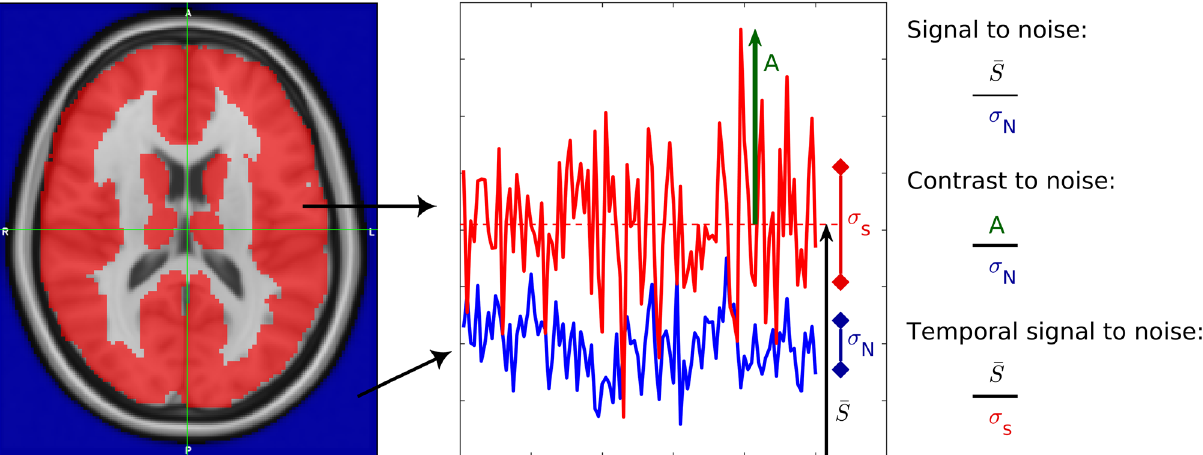
Figure 1. Illustration of the fMRI quality metrics. The red and blue signal represent brain activity and background noise respectively. S is the mean of the brain activity, σ S is the standard deviation of the brain activity, σ N is the standard deviation of the background noise, and A is the amplitude of the maximum peak of the brain